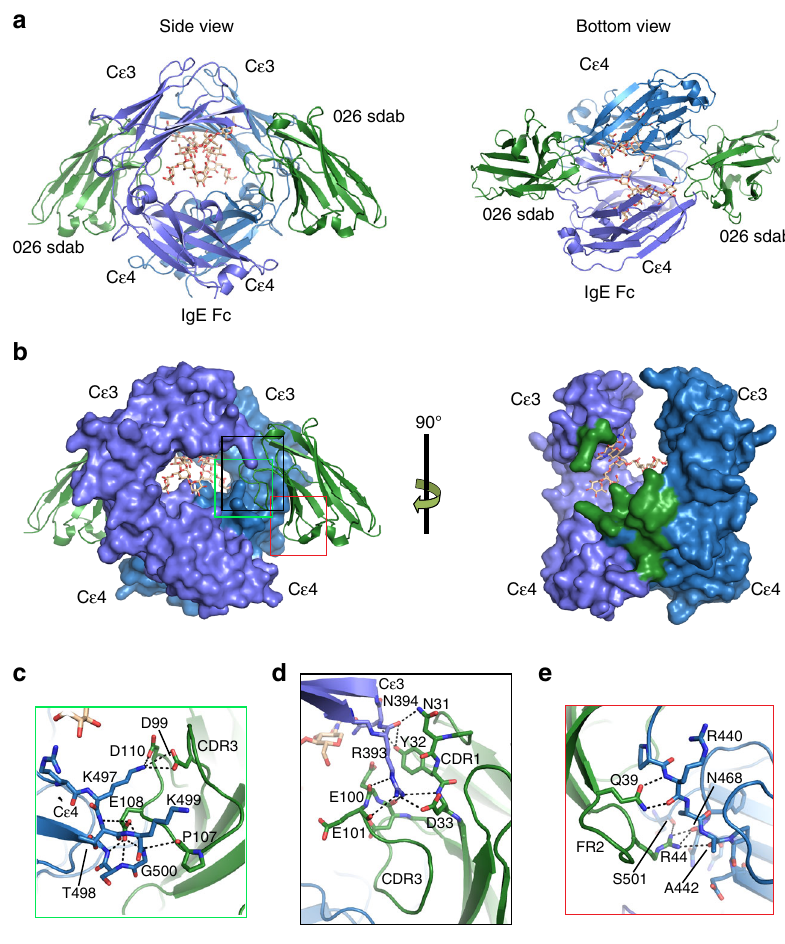
Fig. 2 The 026:IgE Fc complex and the sdab epitope. a A cartoon representation showing IgE Fc C ε 3 – 4 and two 026 sdab molecules binding symmetric sites (green, 026; blue, IgE Fc heavy chain 1; violet, IgE Fc heavy chain 2). The side view of the complex shows the 026 sdab approaching perpendicularly relative to the C ε 3 – 4 domains. A glycan on N394 is located in between the C ε 3 – 4 domains. The bottom view of the complex reveals the two symmetric 026 epitopes on the C ε 3 and C ε 4 domains. b Side view of IgE with bound 026 sdab (left) and without (right). IgE residues in contact with 026 sdab are colored green. c – e Detailed view of the IgE Fc:026 sdab interface, with putative hydrogen bonds and salt bridges shown as dotted